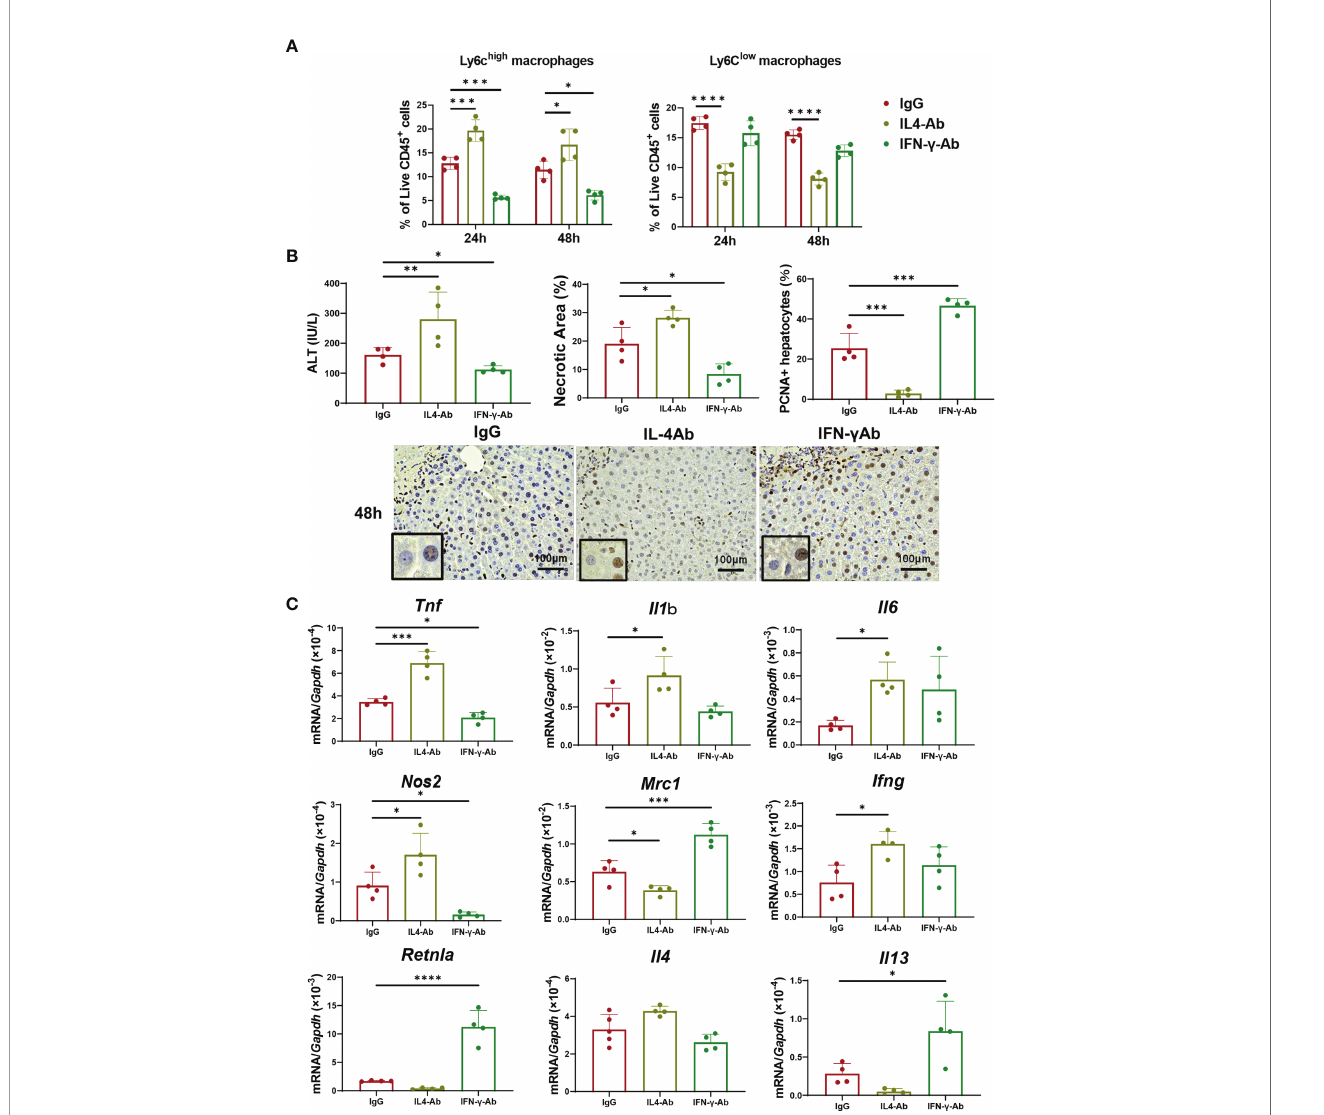
FIGURE 4 | Blockade of IL-4 or IFN- g suppresses macrophage polarization and liver repair after hepatic I/R injury. Anti-IL-4 or IFN- g neutralizing antibodies were administered to mice 1 h prior to the induction of ischemia, and a -GalCer was administered at the induction of ischemia. (A) The percentage of Ly6C high macrophages (Ly6G - /Ly6C high /CD11b high /F4/80 high cells) and Ly6C low macrophages (Ly6G - /Ly6C low /CD11b high /F4/80 high cells) in mice treated with anti-IL-4 antibodies, anti-IFN- g antibodies, or IgG. Data are expressed as the mean ± SD (four biological replicates per group). * P < 0.05, *** P < 0.001, and **** P < 0.0001. (B) ALT levels, hepatic necrosis, and PCNA + hepatocytes (%) in mice treated with anti-IL-4 antibodies, anti-IFN- g antibodies, or IgG. Data are expressed as the mean ± SD (four biological replicates per group). * P < 0.05, ** P < 0.01, *** P < 0.001. Representative images showing immunohistochemical staining of PCNA in mice treated with anti-IL-4 antibodies, anti-IFN- g antibodies, or IgG at 48 h post-reperfusion. Large and rounded cells are considered hepatocytes, and typically labeled hepatocytes are shown at the lower-left corner. Scale bar, 100 m m. (C) Expression of genes related to pro-in fl ammatory ( Tnf, Il1b, Il6, Nos2, and Ifng ) and reparative macrophage phenotypes ( Mrc1, Retnla, Il4 , and Il13 ) after hepatic I/R injury in mice treated with anti-IL-4, anti-IFN- g , or IgG antibodies. Data are expressed as the mean ± SD (four biological replicates per group). * P < 0.05, *** P < 0.001, **** P <